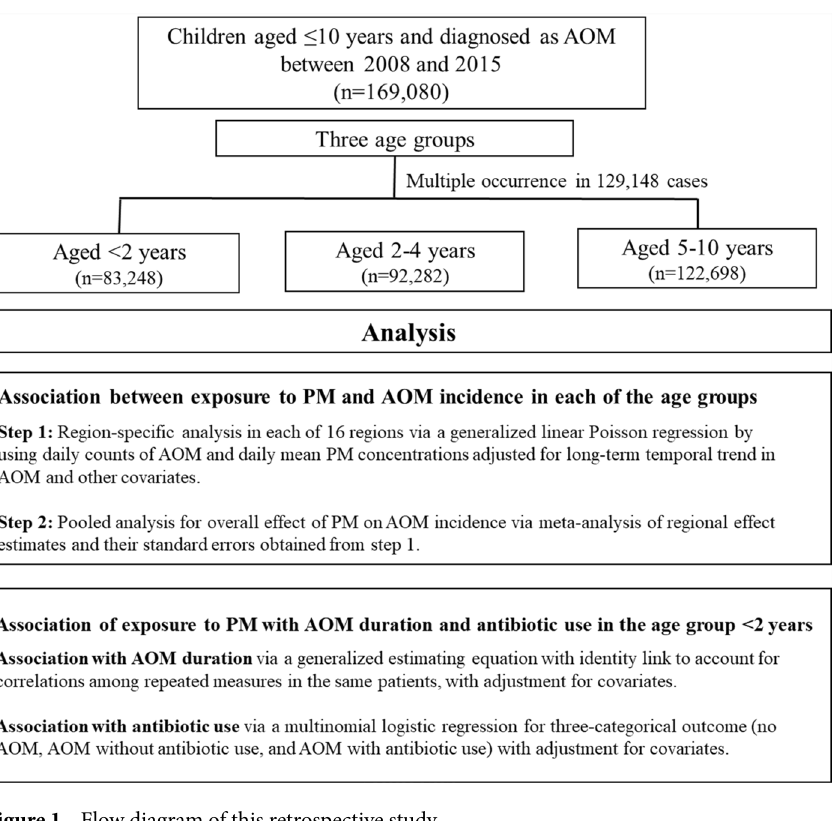
Figure 1. Flow diagram of this retrospective